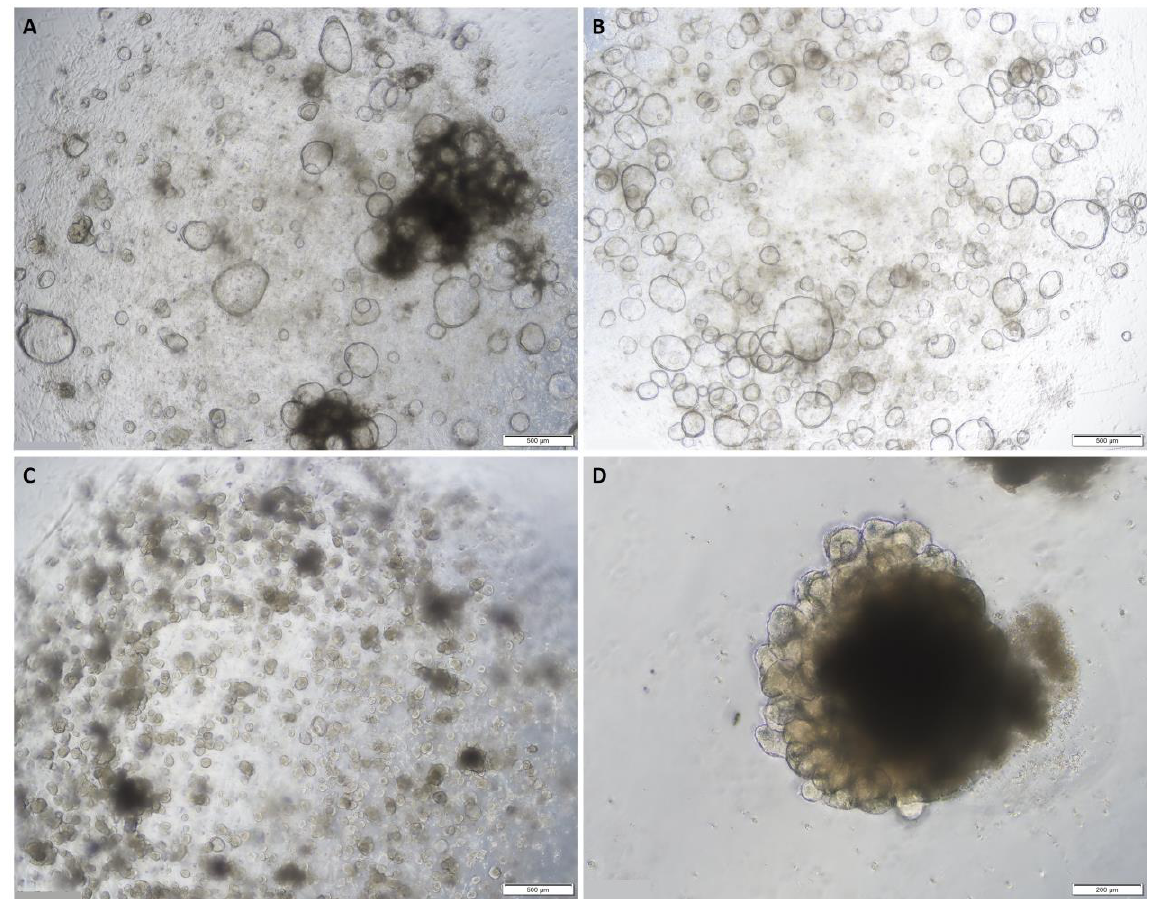
Figure 1. Representative images of normal colon organoids: ( A ) on day 7 of passage 1 showing cystic organoids with large hollow lumens; ( B ) on day 8 of passage 1 showing cystic organoids with large hollow lumens; ( C ) on day 7 of passage 2 showing more compact organoids; ( D ) on day 5 of passage 6 showing epithelial budding. Original magnification: 4× ( A – C ) and 10× ( D ).